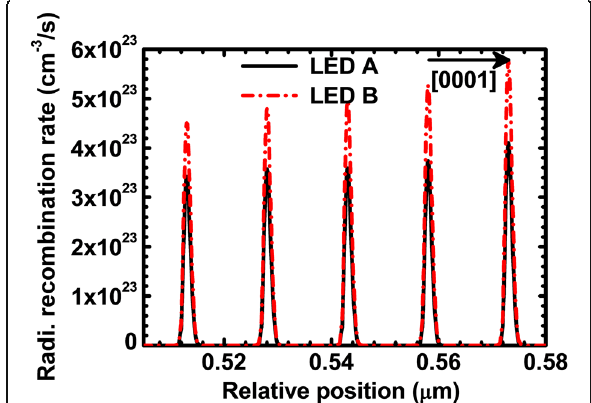
Fig. 4 Numerically computed profiles of the radiative recombination rate for LEDs A and B. Data are collected at the current density level of 50 A/cm 2